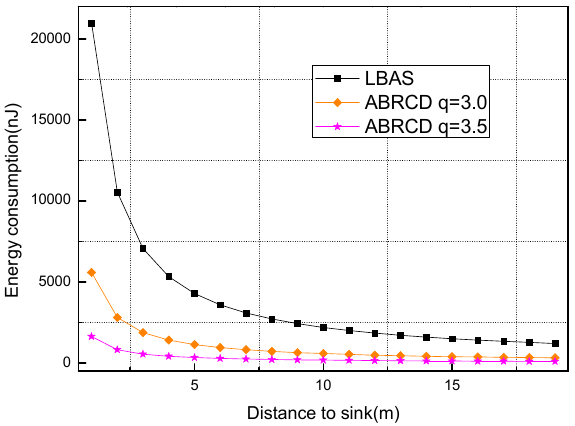
Figure 18. Energy consumption of nodes 1~19 m away from sink with different q (1.5, 2.0 and 2.5).